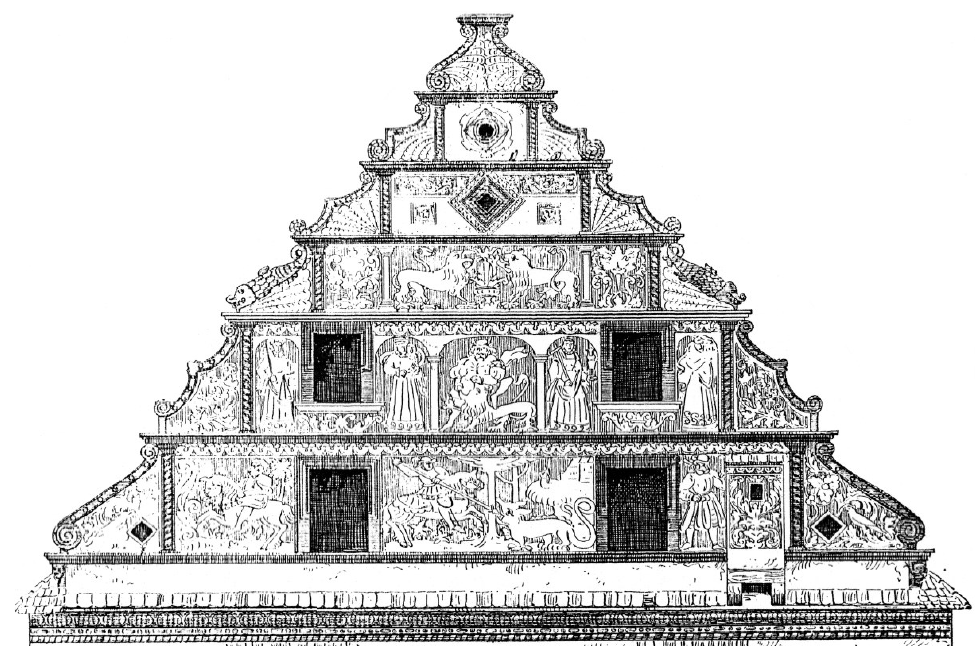
Figure 30. Inventory of the decoration of the southern gable of the manor house in Pawłowice from 1903. Source: Lutsch (1903, vol. 5, p. 35).